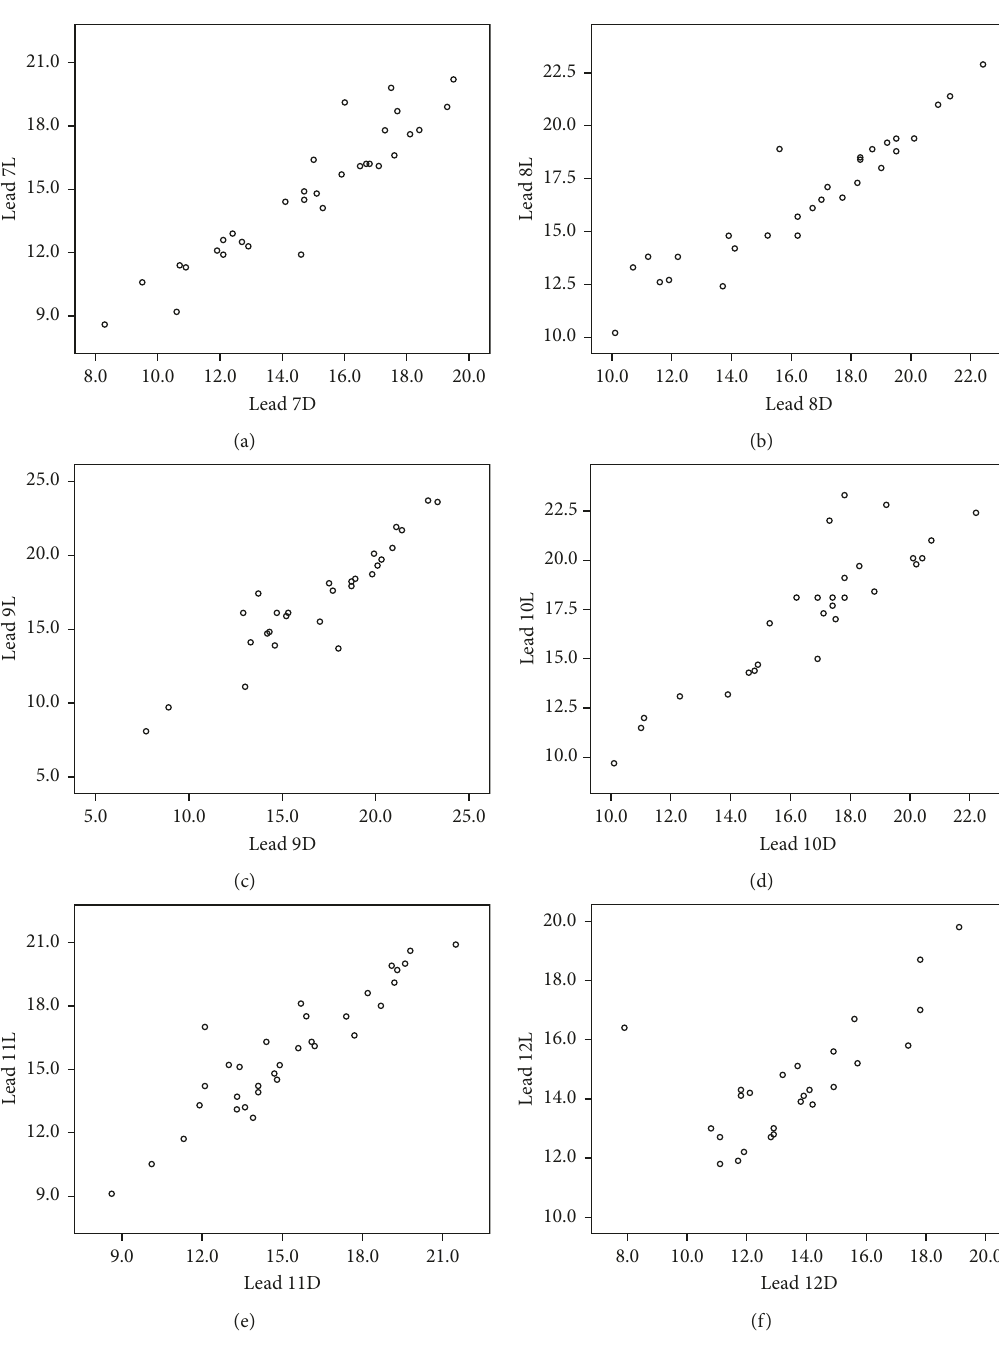
Figure 2: Scatter plots for the individual amplitudes of e-ECAP in the light and deep anesthesia in lead 7 (a), lead 8 (b), lead 9 (c), lead 10 (d), lead 11 (e), and lead 12 (f). The absolute differences showed no statistical difference. Thus, the variation is not clinically